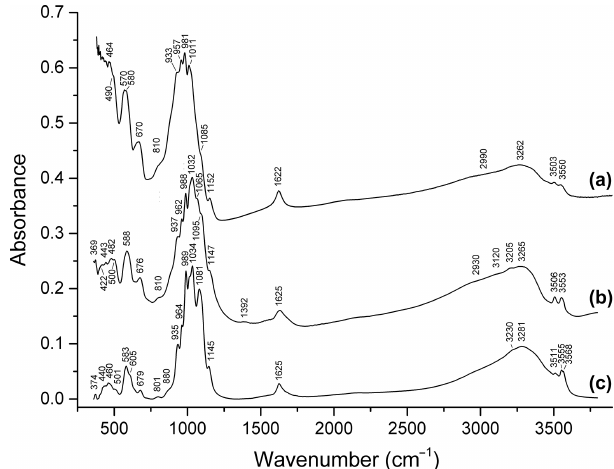
Figure 8. Infrared spectra of (a) beraunite neotype, (b) beraunite (Fe 3 + Al 0 . 18 Mn 3 + ) (cid:54) 6 . 03 (PO 4 ) 3 . 92 O(OH) 4 . 34 · 5.98H 2 O from 5 . 76 0 . 09 the Rotläufchen mine (Chukanov et al., 2017), and (c) Mn-rich be- raunite (Mn 2 + Zn 0 . 13 Mg 0 . 04 Fe 3 + ) (cid:54) 5 . 98 (PO 4 ) 4 (H 2 O,OH,O) 11 0 . 58 5 . 24 from Waidhaus, Upper Palatinate, Bavaria, Germany (Aksenov et al.,